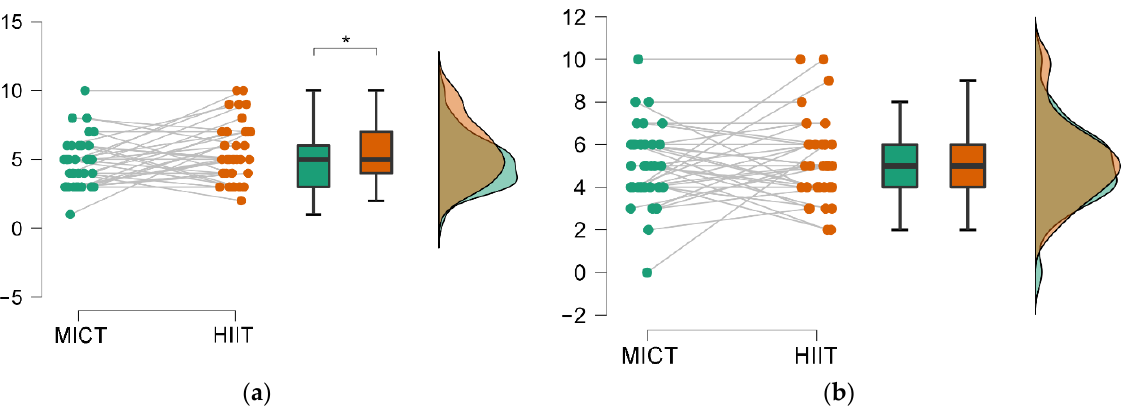
Figure 5. Raincloud plots for the formal memory results. ( a ) Recall at 48 h; ( b ) Recall at 7 days. *: Indicates a significant effect of time or between conditions.